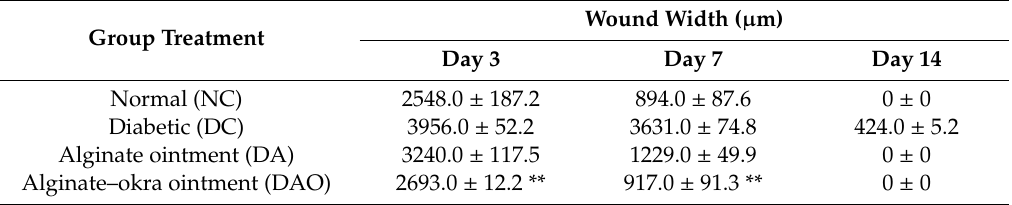
Table 3. Counts considering the mean and standard deviation of wound width.